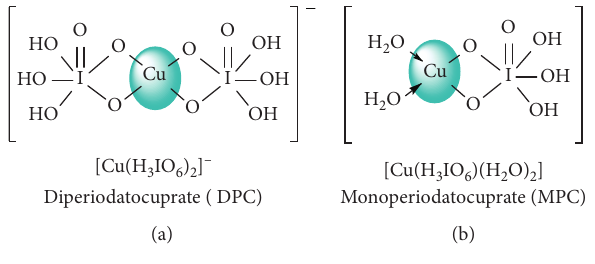
Figure 2: Structure of (a) DPC (III) and (b) MPC (III).